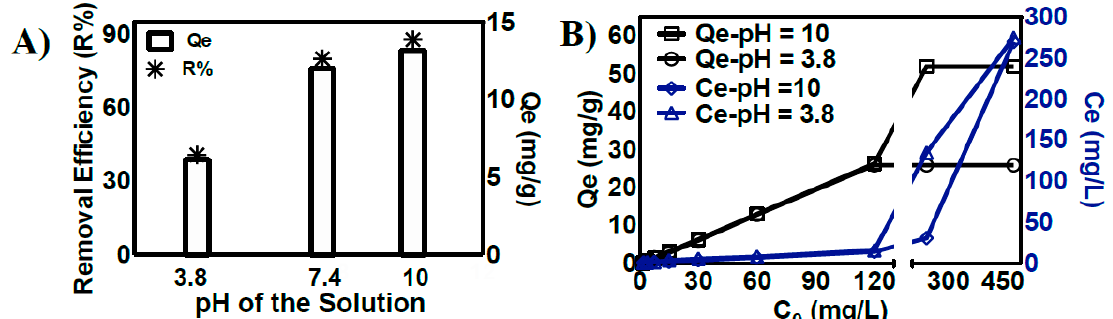
Figure 3. ( A ) Effect of pH on the amount of iron adsorbed at equilibrium (Qe, mg/g) and its removal efficiency (R%) in the presence of a constant amount (4 g/L) of polymeric composite. ( B ) Analysis of iron adsorbed at equilibrium (Qe, mg/g) on the surface of the composite and the concentration of free iron (Ce), as a function of iron concentration in solution, at pH 3.8 and pH 10.